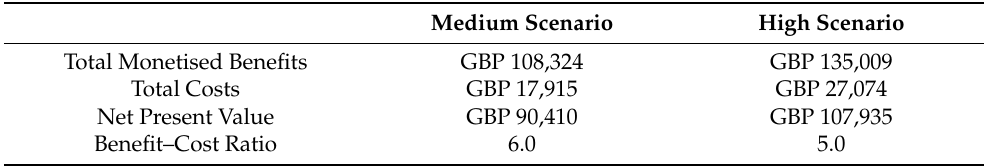
Table 2. Summary cost–benefit analysis results for the medium and high scenarios, 2023–2040, discounted at 3.5% (2020 prices, GBP